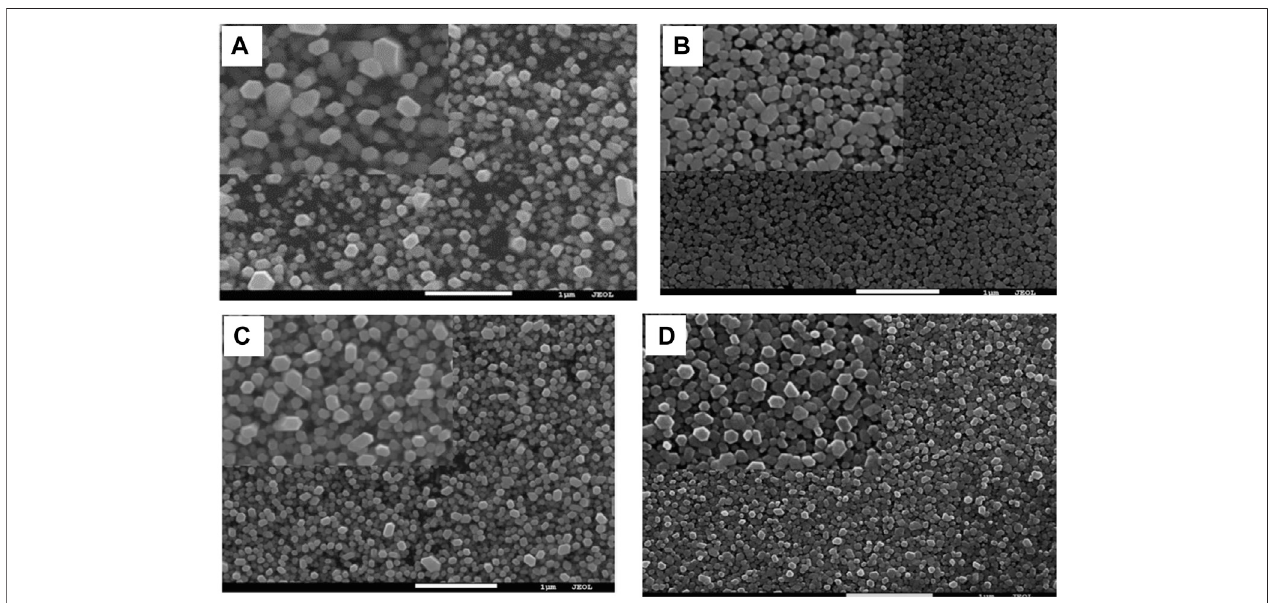
FIGURE 3 | SEM images of ZnO nanorods with various growth times, Top view (A) 1 h, (B) 2 h, (C) 3 h, (D) 4 h (Hussain et al., 2015).